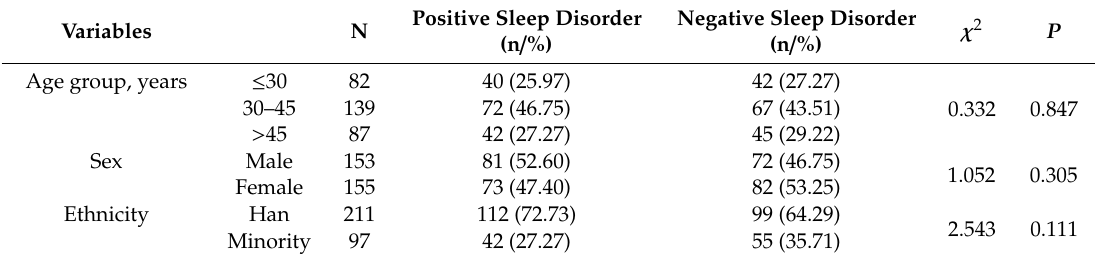
Table 4. Balance test between positive sleep disorder groups and negative sleep disorder groups.